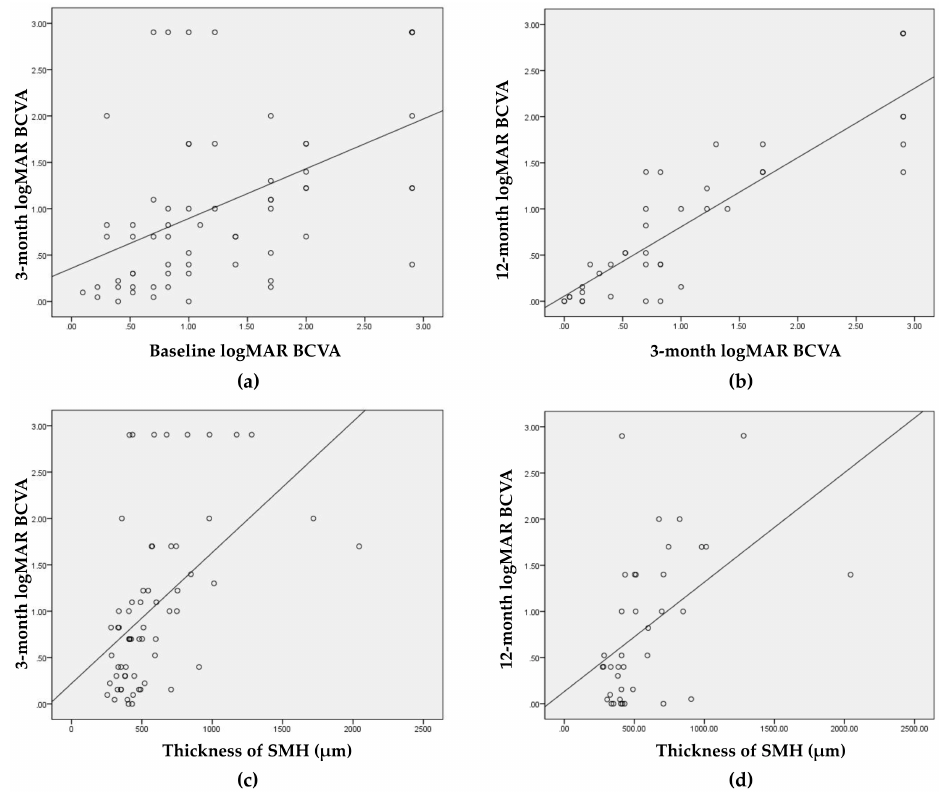
Figure 2. Scatter plots comparing ( a ) baseline BCVA and postoperative BCVA at 3 months and ( b ) BCVA at 3 months and at 12 months, as well as SMH thickness and ( c ) BCVA at 3 months and ( d ) BCVA at 12 months. BCVA, best-corrected visual acuity; LogMAR, logarithm of the minimum angle of resolution; SMH, submacular hemorrhage.